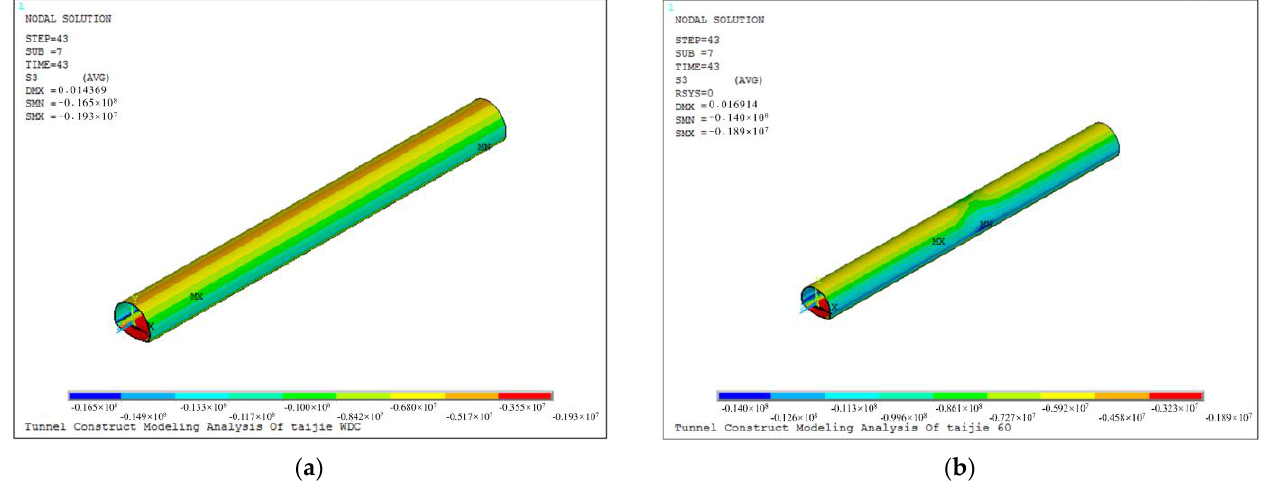
Figure 17. Comparison of lining stress: ( a ) no fault and ( b ) 60° fault dip.